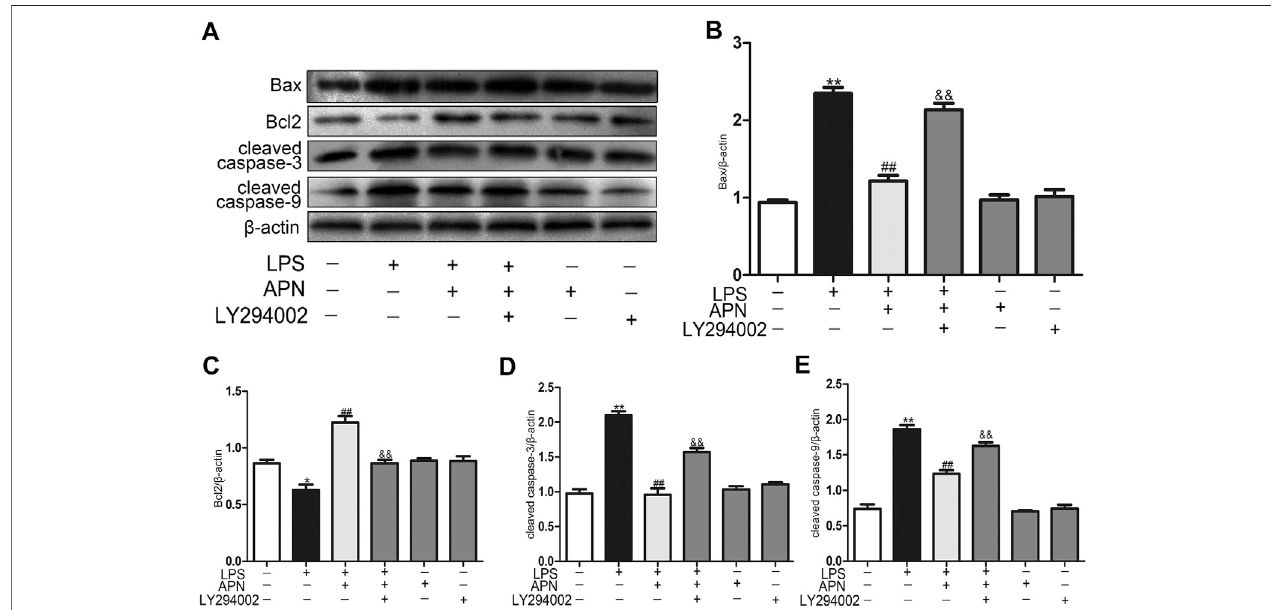
FIGURE4| PI3K/AKTpathwayinhibitionalterstheeffectofAPNonLPS-inducedapoptosisinH9c2cells. (A) TheeffectsofAPN,LY294002andLPSonBax,Bcl2, cleaved caspase-3 andcleaved caspase-9protein levels. (B – E) Statistical analysis.(* p < 0.05, ** p < 0.01vs. control; # p < 0.05, ## p < 0.01vs. theLPSgroup; & p < 0.05, && p < 0.01 vs. the LPS + APN group. The data are shown as the means ± SEs (n (cid:2)